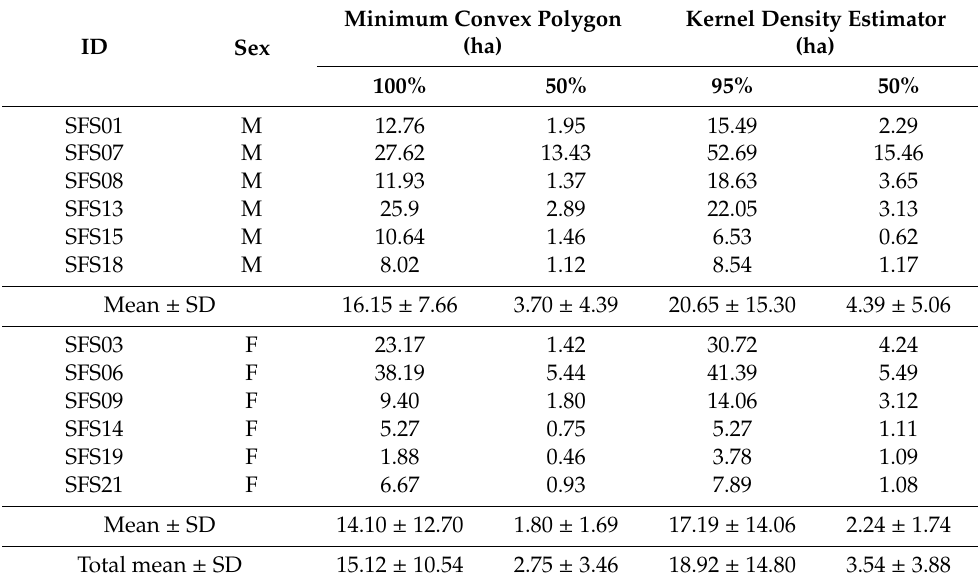
Table 3. Estimates of the home range and core area of Siberian flying squirrels at Mt. Baekwoon, Gangwon Province, South